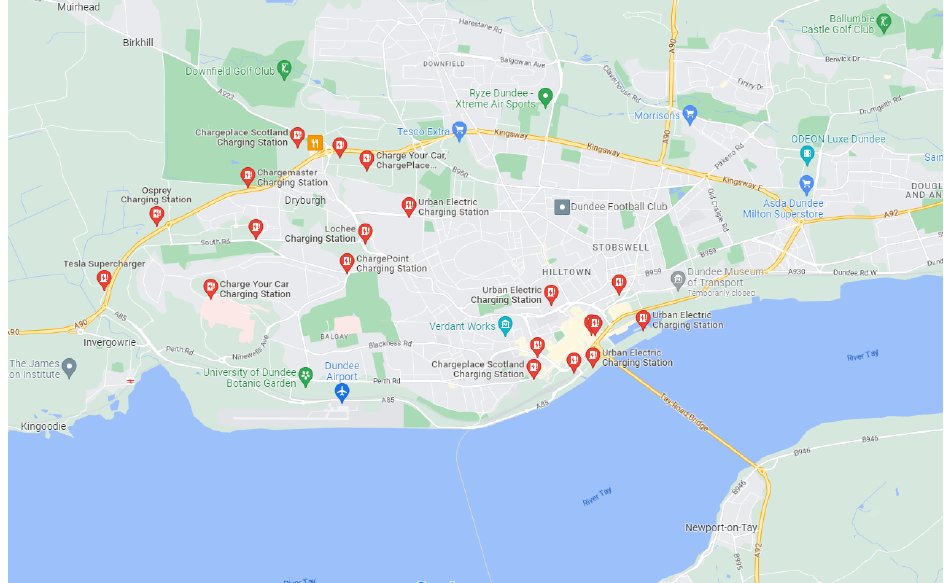
Figure 6. Locations of EV charging points. Charging points distribution in Dundee City is shown in the